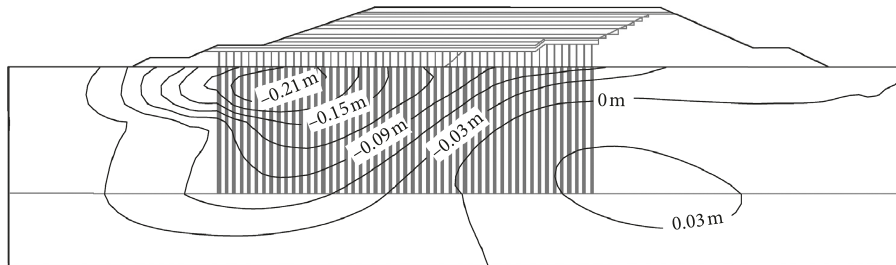
Figure 8: Simulated lateral displacement profile at the end of construction.